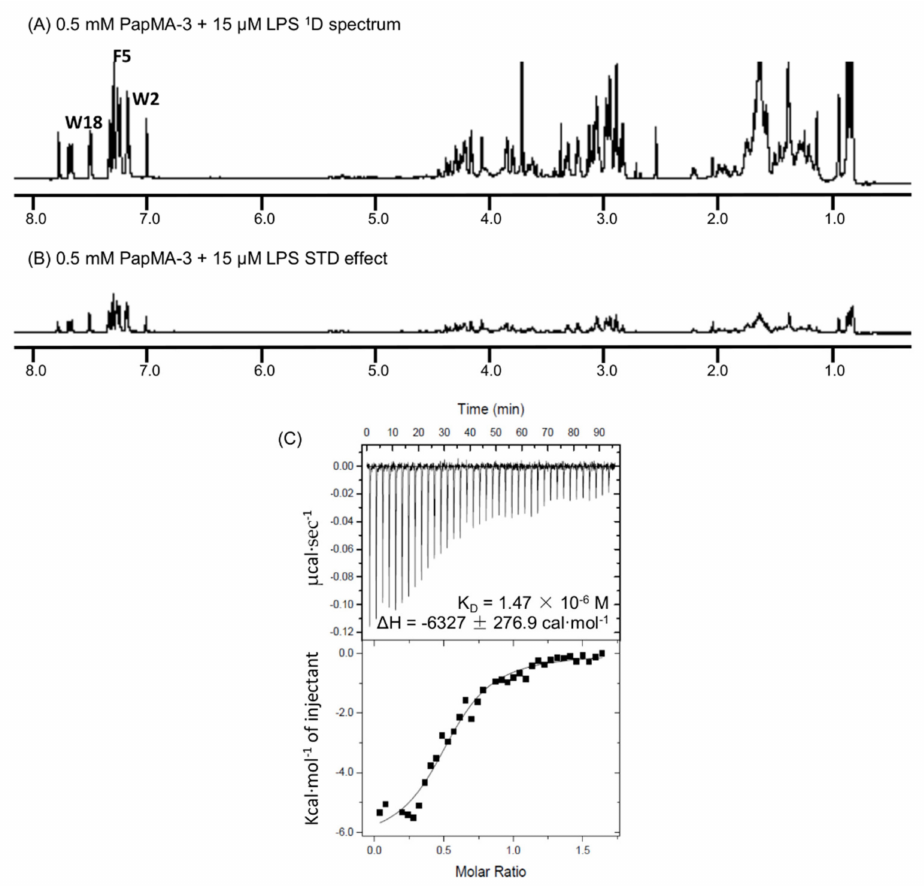
Figure 11. Binding interaction of PapMA-3 with LPS. Saturation transfer difference (STD) NMR analysis of interaction between PapMA-3 and LPS in D 2 O at 298 K. ( A ) 1 D 1 H NMR spectra of 0.5 mM PapMA-3 plus 15 µ M LPS (sample A), ( B ) STD NMR spectrum obtained on sample A at 298 K. ( C ) Isothermal titration calorimetry (ITC) measurement showing the binding affinity of 0.2 mM PapMA-3 to 0.025 mM LPS from E. coli